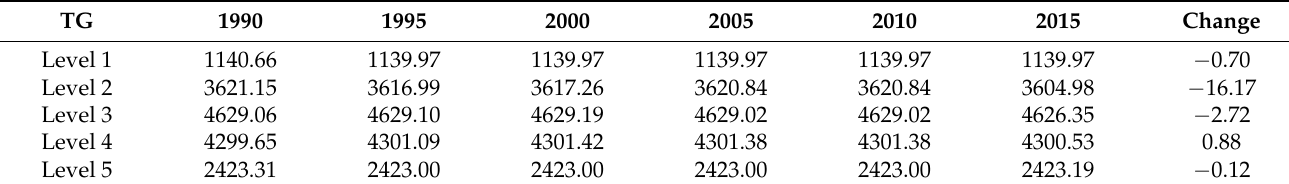
Table 2. Change in ESV in Shannan based on TG from 1990 to 2015 (CNY/hm 2 ).